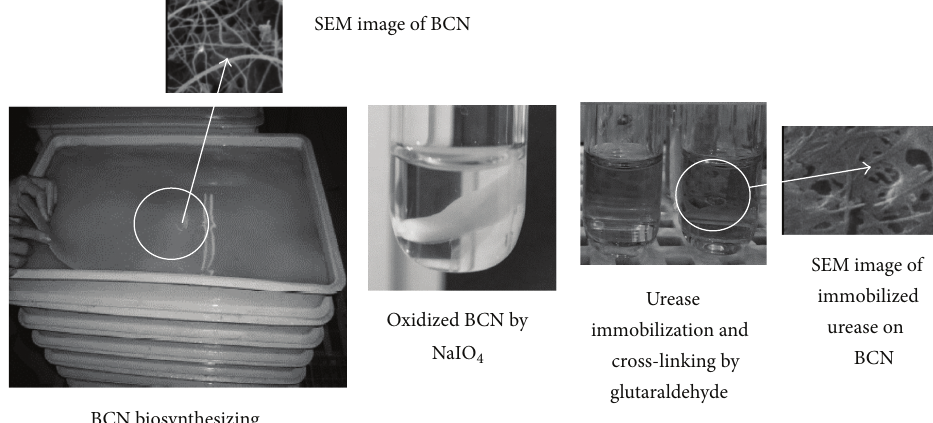
Figure 1: Diagram of BCN preparation and urease